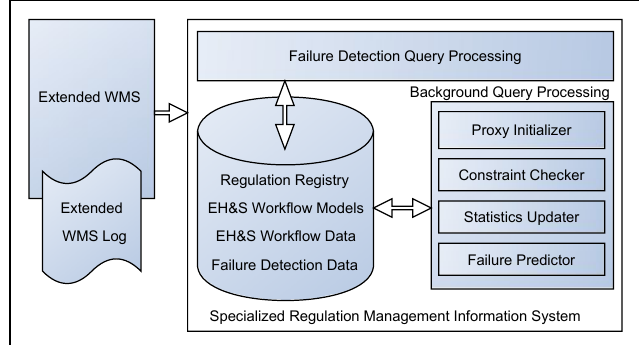
Fig. 4. High-level architecture of